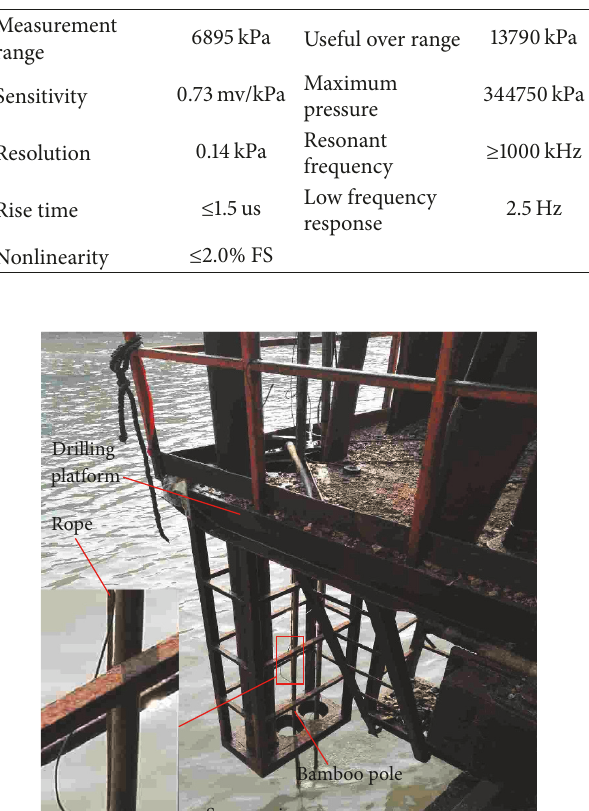
Table 1: Basic sensor performance indicators.